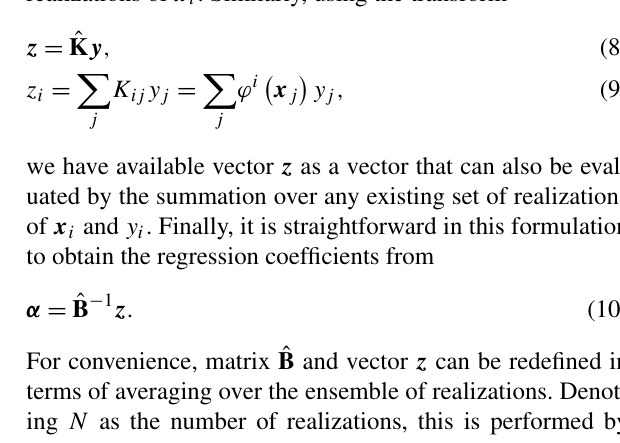
Figure 1. Deviation statistics induced by simulated refractivity fluctuations: refractivity structure constant C 2 difference statistics of ECMWF profiles with and without fluctuations superposed for bending angle as function of impact altitude (b) and refractivity as function of altitude (c) , where mean difference (red), standard deviation (green), and the difference-ensemble spread (horizontal bars at vertical levels) are shown. COSMIC event geometry and concurrent ECMWF analysis fields from the 15th day of every month of year 2008 were used to produce the